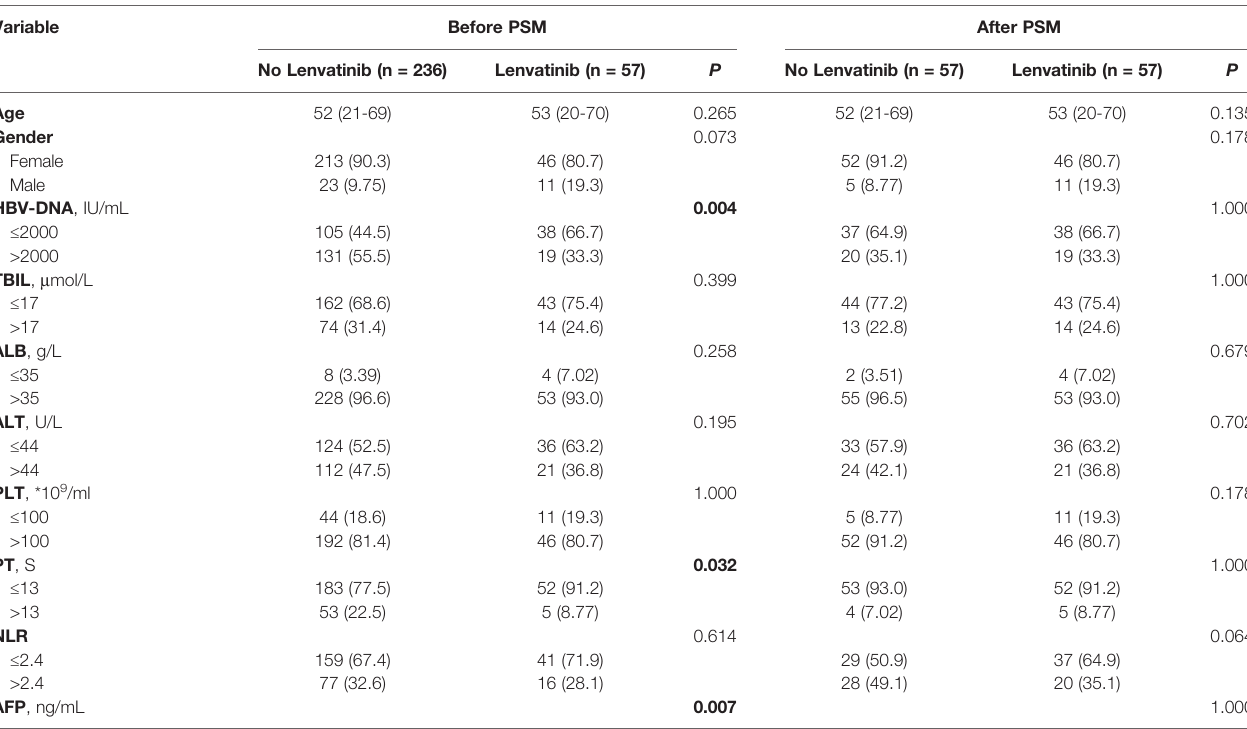
TABLE 1 | Basal clinicopathological characteristics of 293 HCC patients with Microvascular Invasion with and without adjuvant Lenvatinib. Variable Before PSM After PSM No Lenvatinib (n =